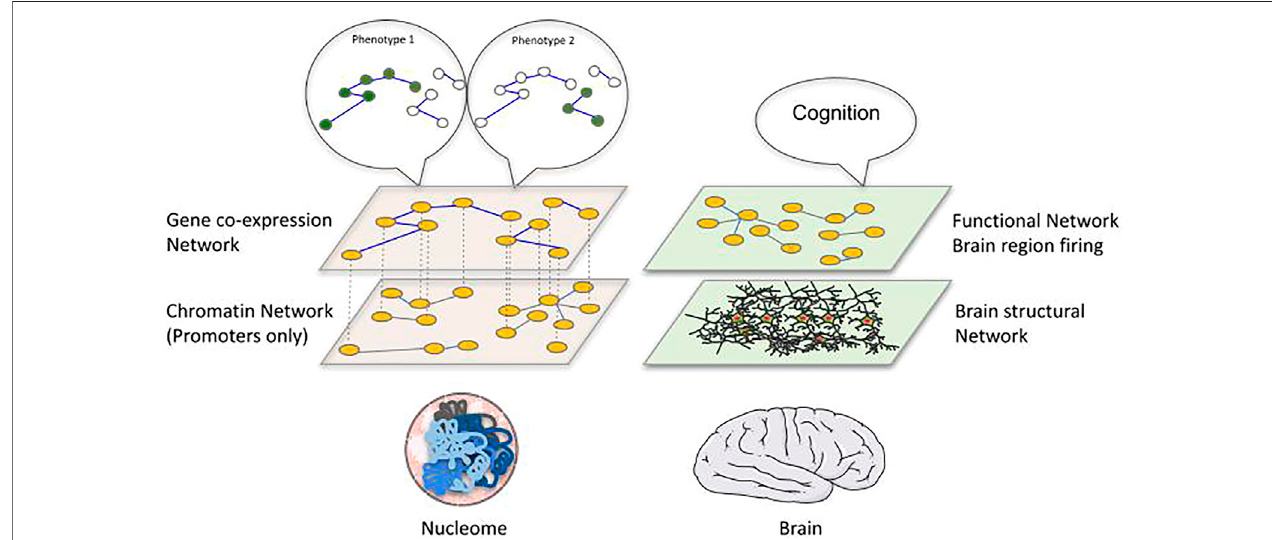
FIGURE 2 | Proposing a structure-function relationship linking the epigenome to the phenotype. We propose an analogy between the brain and chromatin represented as multilayer networks. In the brain, a structural network of physical connections between neurons and brain regions can be identi fi ed and related to a functional network describingcorrelation in fi ring of distant brain regions, which collectively give rise to cognitive functions. Similarly, the physical interactions of genomic regions inside the nucleus (left bottom layer: chromatin network, nodes are gene promoters with contacts retrieved by promoter-capture Hi-C) can be related to gene-coexpression networks (left top layer: nodes are genes and edges represent correlation of expression between them across different conditions) that ultimately determine cellular phenotypes, which can be interpreted as speci fi c gene expression patterns associated to distinct